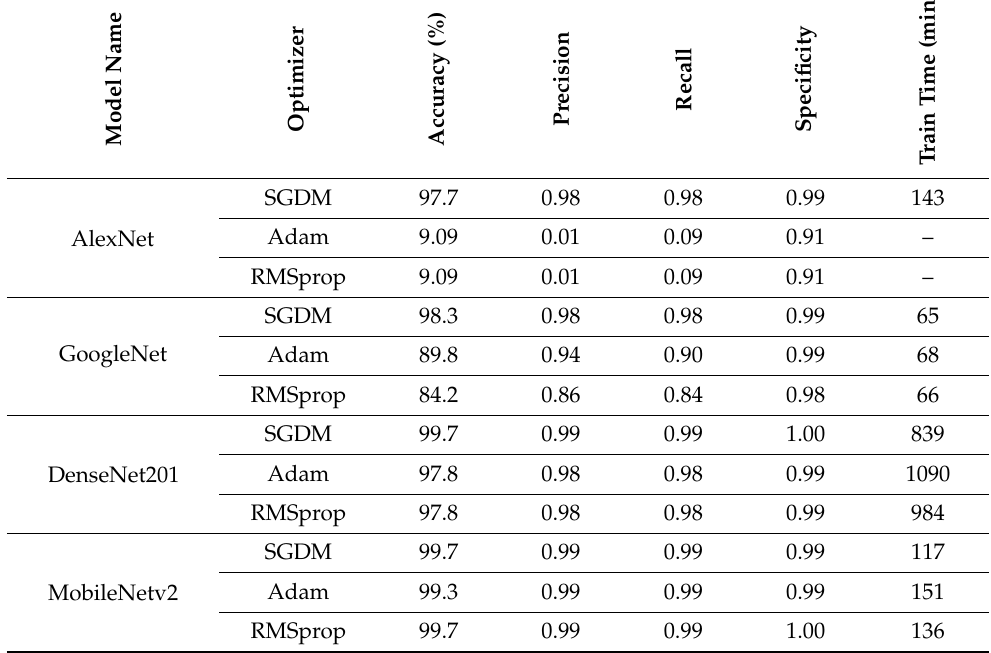
Table 5. Performance Metrics for BW QR